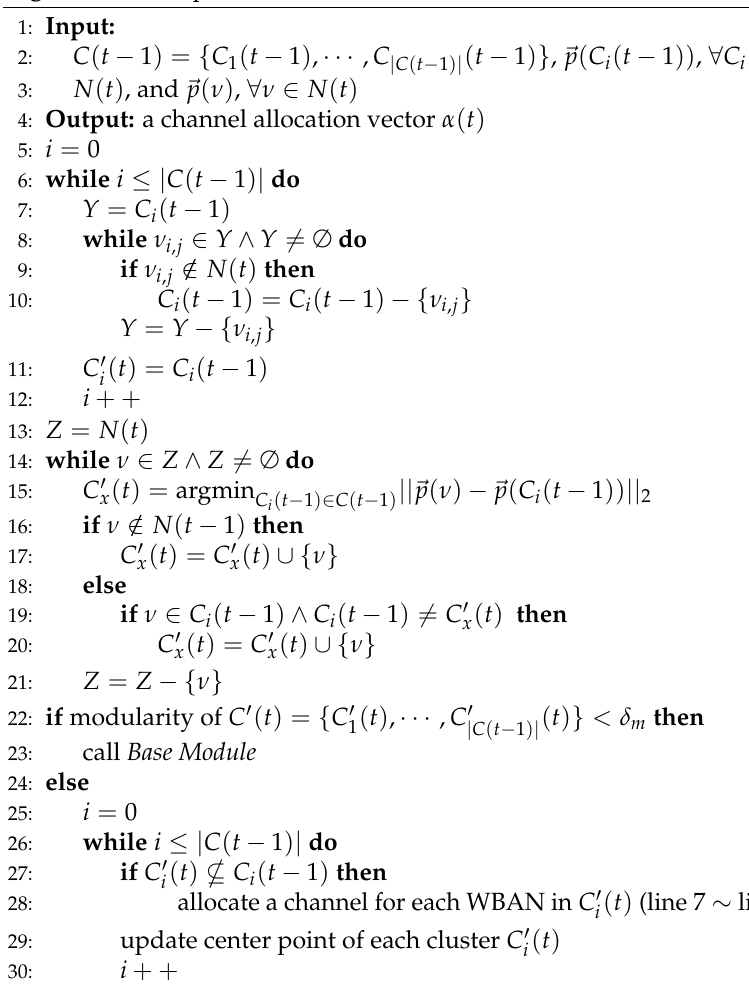
Algorithm 2 Adaptive